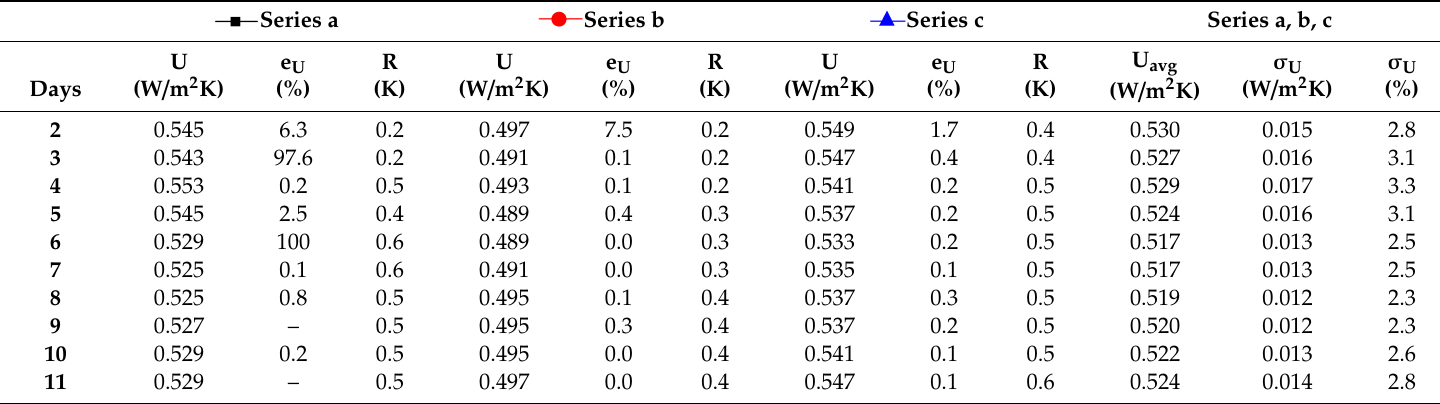
Table 9. Ceiling. Comparison of the results for di ff erent test lengths. U using the 4 nodes model without solar radiation and T i as output. Series